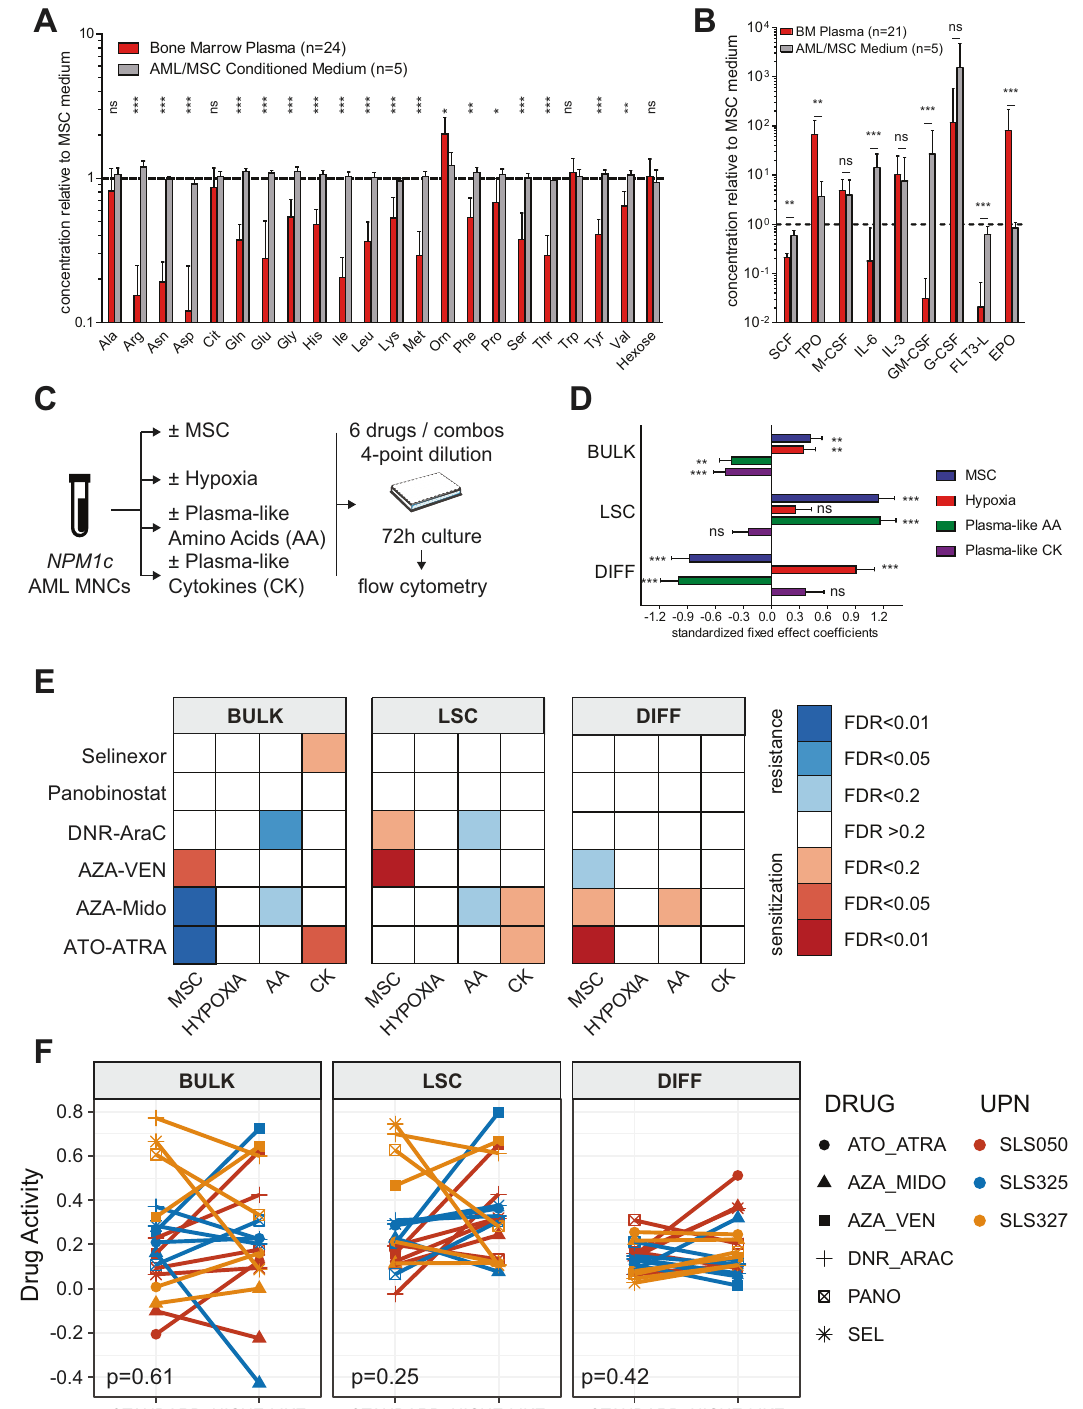
Fig. 3 Plasma-like interacts with other pseudo-niche factors to dictate leukemic cell states and drug response ex vivo. A , B Amino-acid and hexose levels ( A AbsoluteIDQ ® p180 Assay, Biocrates) and cytokine levels ( B custom U-Plex ® , MesoScale Discoveries) from 21 – 24 diagnostic AML BM plasma samples and fi ve AML/MSC co-cultures conditioned media relative to conditioned medium of MSC alone. Mean + SD. FDR q values from Mann – Whitney tests for the comparison of BM plasmas versus AML/MSC conditioned media. C Work fl ow of a mini- screen to systematically interrogate the contribution of the four pseudo-niche components (MSC, 3% O 2 , plasma-like amino acids, and cytokines) on leukemic states and drug sensitivity. D Fixed effects estimates (with SD) from mixed effect models investigating the contribution of each pseudo-niche component on each readout in the vehicle (DMSO 0.1%) treated cells from three NPM1 -mutated AMLs, with random effect terms for patients. P values are from the mixed effect models. * p or q < 0.05, ** p or q < 0.01, *** p or q < 0.001. E Heatmap of FDR q values for the impact of each pseudo-niche component on drug activity for each readout and drug, based on mixed-effect models with a random effect for patients. F Drug activities for each readout in standard versus niche-like conditions. P values from Wilcoxon signed-rank tests. Drug activity ranking in each patient is provided in Supplementary Fig.